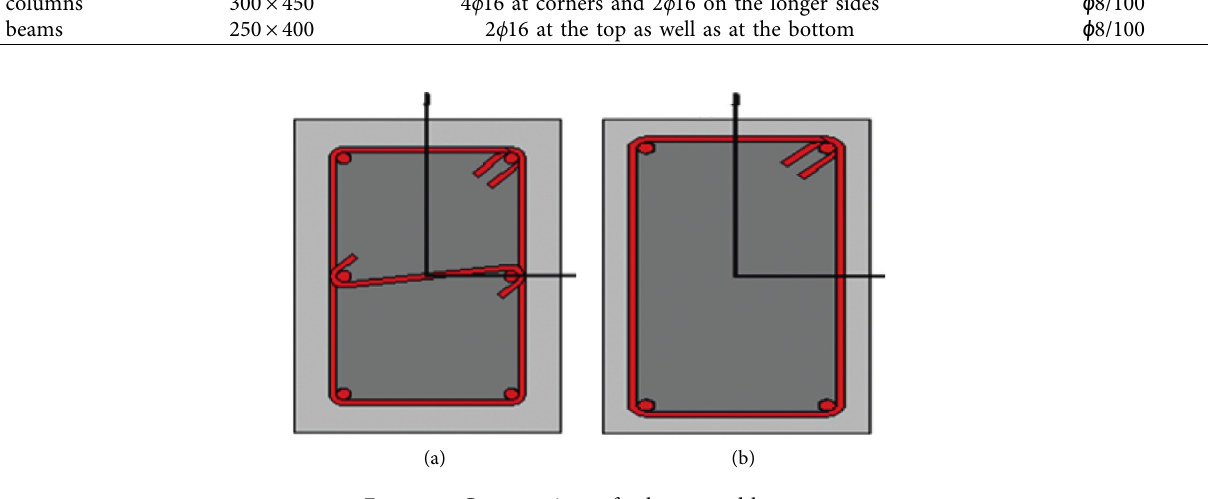
Figure 5: Cross-sections of columns and